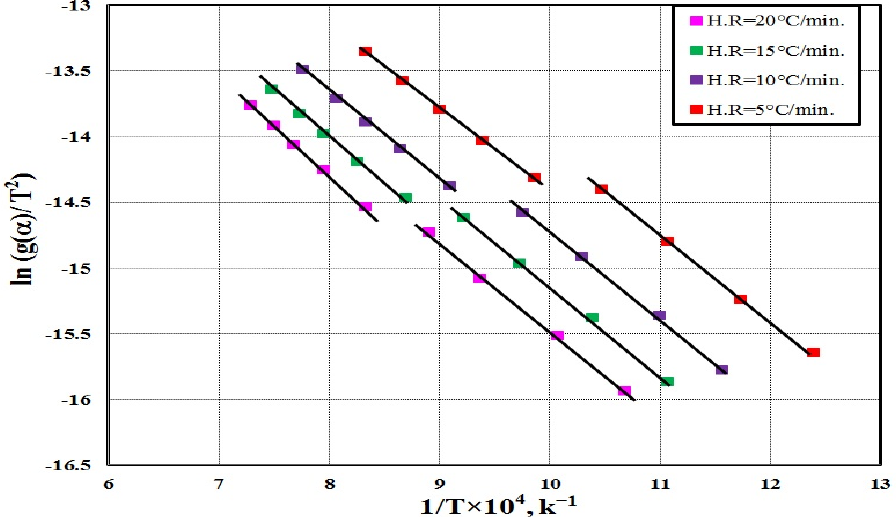
Figure 12. Coats–Redfern plot of Fe 2 O 3 /charcoal composite at two weight loss stages. The values of computed Ea at different conversion degrees ( α ) are given in Figure 13.